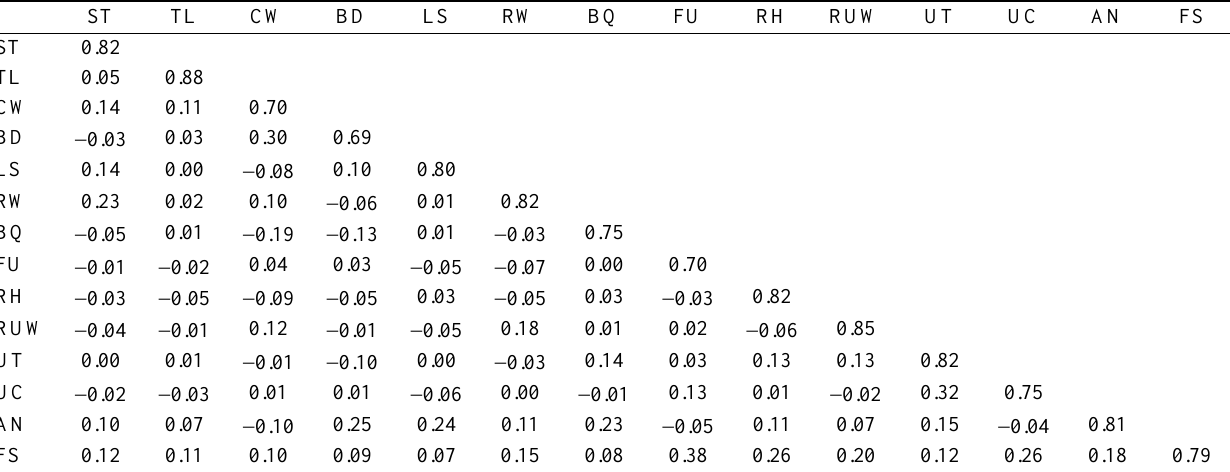
Table 2. Measurement of sample adequacy (MSA) and partial correlations* between linear type traits ST TL CW BD LS RW